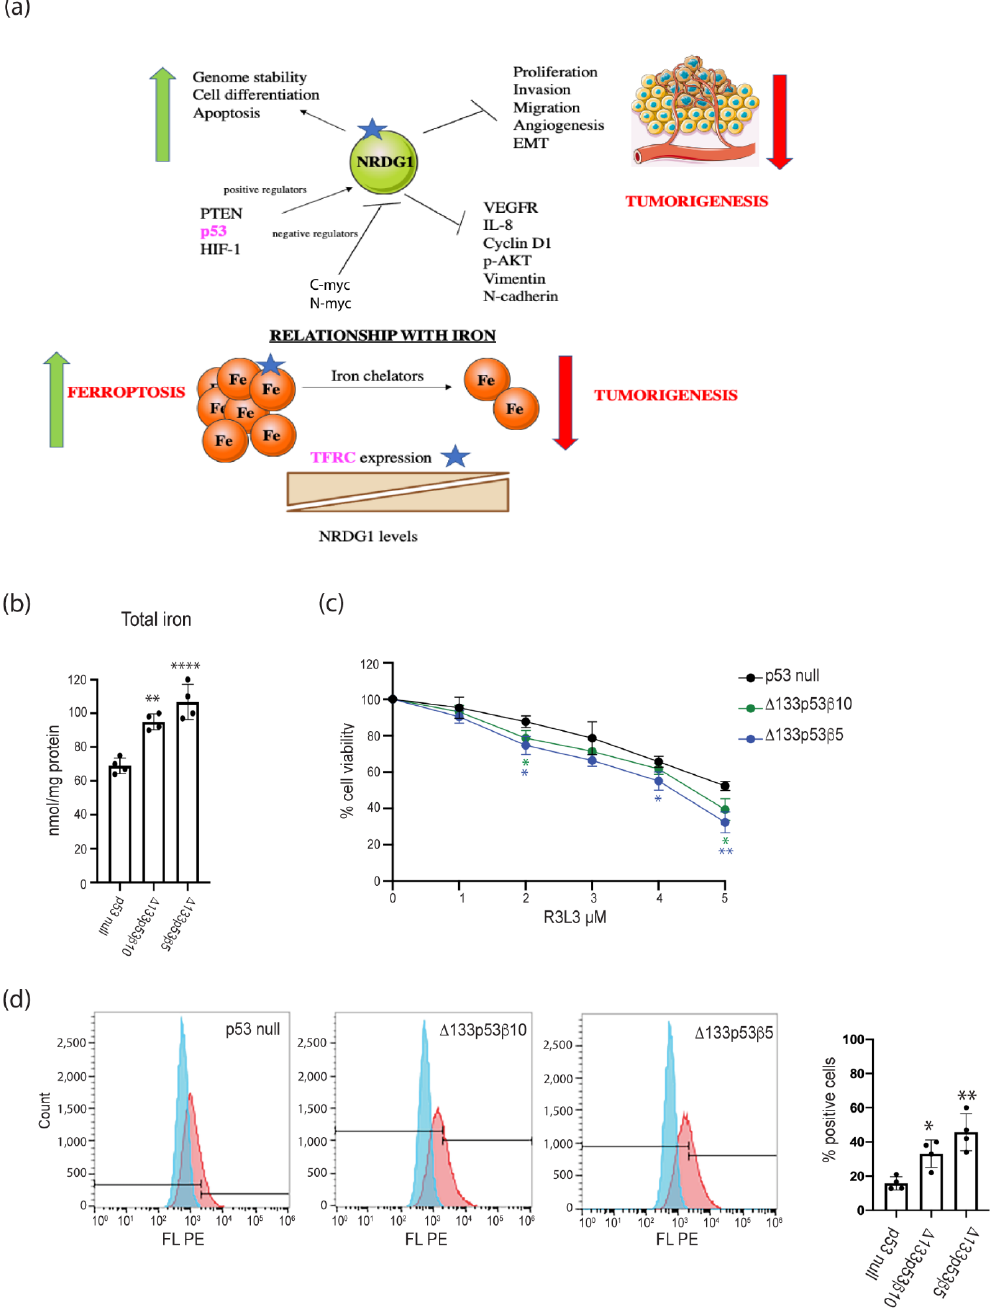
Figure 8. Increase in cell surface proteins can be used to target Δ 133p53 β cells. ( a ) Increased TFRC and decreased NRDG1 promoted tumorigenesis, including intracellular iron concentrations. Green arrows, pathways increased; red arrows, pathways decreased. Blue stars, potential therapeutic targets to affect Δ133p53β function. ( b ) Comparison of total intracellular iron concentrations. ( c ) Comparison of cell viability following ferroptosis induction with R3L3. ( d ) Left: histograms for the measurement of cellular lipid peroxidases (blue signifies unstained cells, red signifies cells incubated with C-11 BODIPY) using flow cytometry. Right: comparison of the percentages of C11-